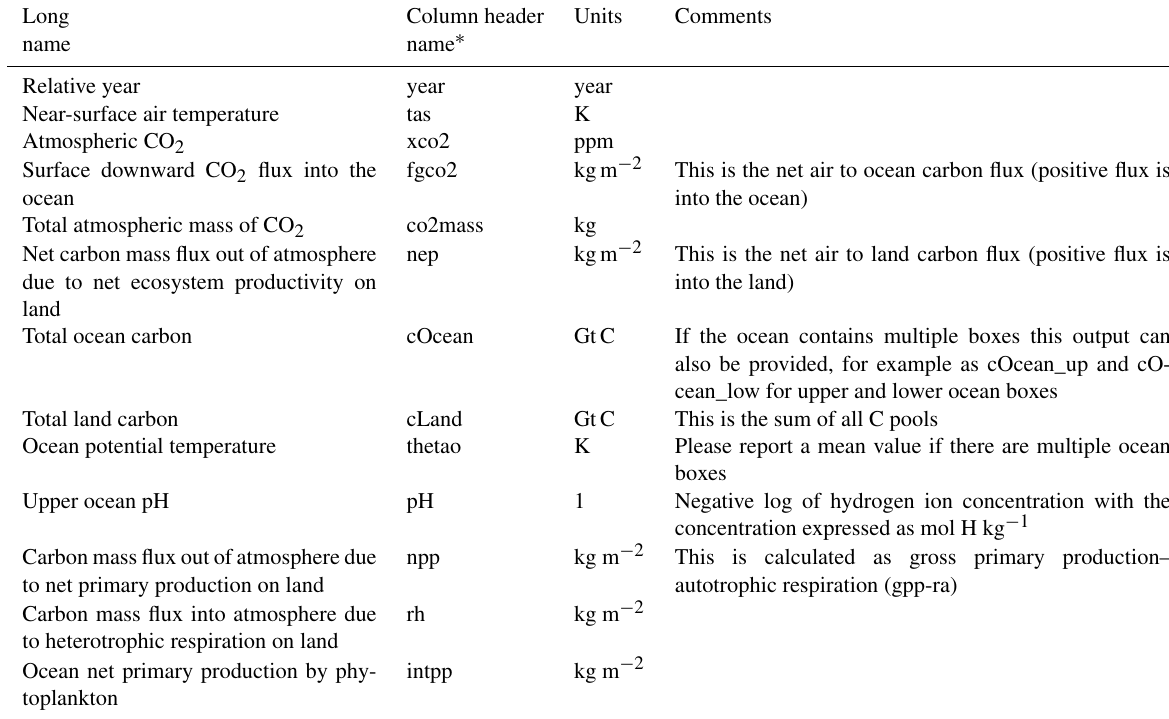
Table C1. Requested box model output for